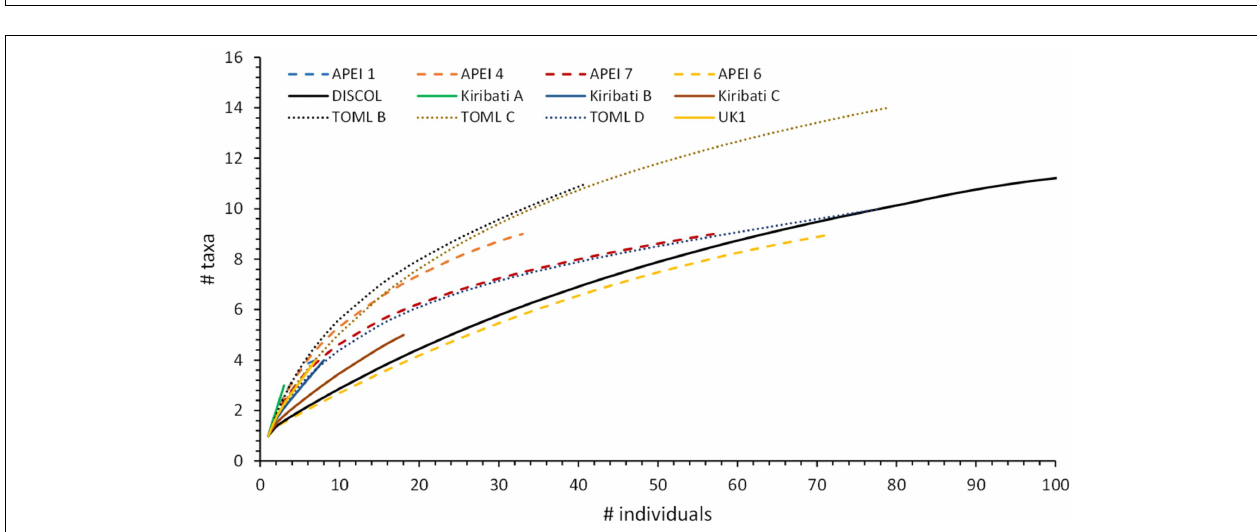
FIGURE 3 | Rarefied fish diversity from quantitative camera transect data by region. Note that for DISCOL considerably more fish were observed and the curve extends to 17 taxa.